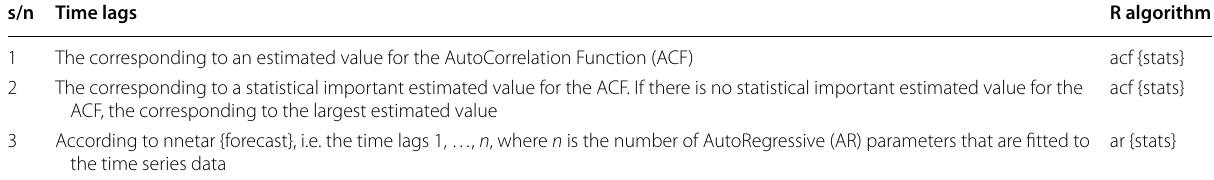
Table 7 Error metrics and accuracy statistics of this study